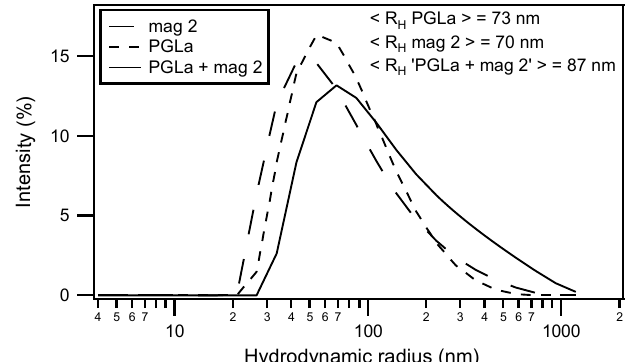
Figure 3. Dynamic light s cattering (DLS) size measurement of LUVs made of 440 µ M POPE/POPG (3/1) and incubated with magainin 2 (long dashed line), PGLa (short dashed line) or an equimolar mixture of PGLa and magainin 2 (continuous line) in 10 mM Tris-HCl buffer pH 7. The vesicles were made by mechanical extrusion through a 100 nm pore filter and the peptide to lipid ratio was kept constant at P/L = 3.6% for all tree measurements (this corresponds to the same condition for peptide injection at t ≈ 2030 s in Figure 2C). The averaged hydrodynamic radius < R H > is indicated in the upper right of the graphs.